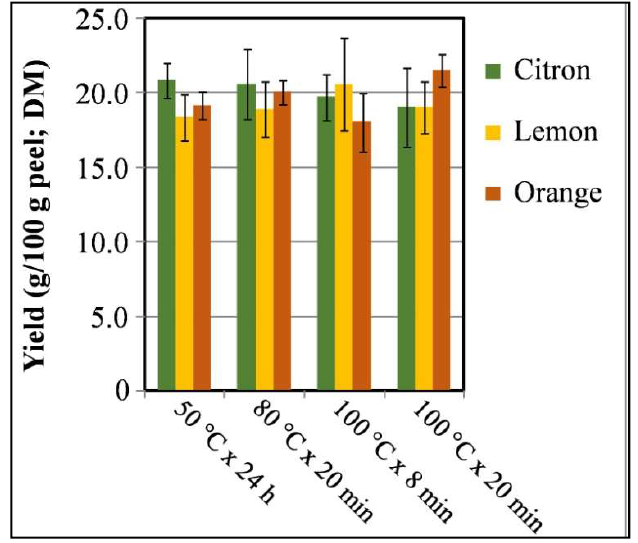
Figure 1. Mean yield percentages (as dry matter) of water extracts obtained from citron, lemon, and orange peels upon hot water extraction (HWE) (50 °C × 24 h) and microwave assisted extraction (MAE) (80 °C × 20 min, 100 °C × 8 min, 100 °C × 20 min). Bars represent standard deviations ( n = 3). (80 ◦ C × 20 min, 100 ◦ C × 8 min, 100 ◦ C × 20 min). Bars represent standard deviations ( n =